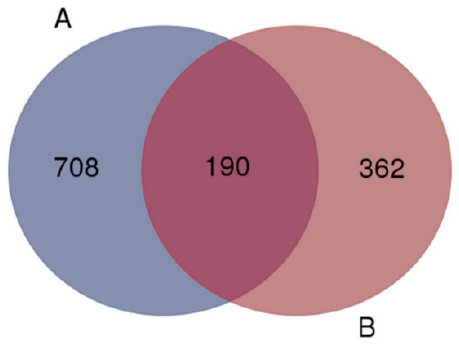
Figure 1. Potential targets of miR-155 identified by miRTarbase and TargetScan. ( A ) miRTarbase identification; ( B ) TargetScan identification. 190 mRNAs were overlapped by bioinformatic analyses, which future studies may wish to